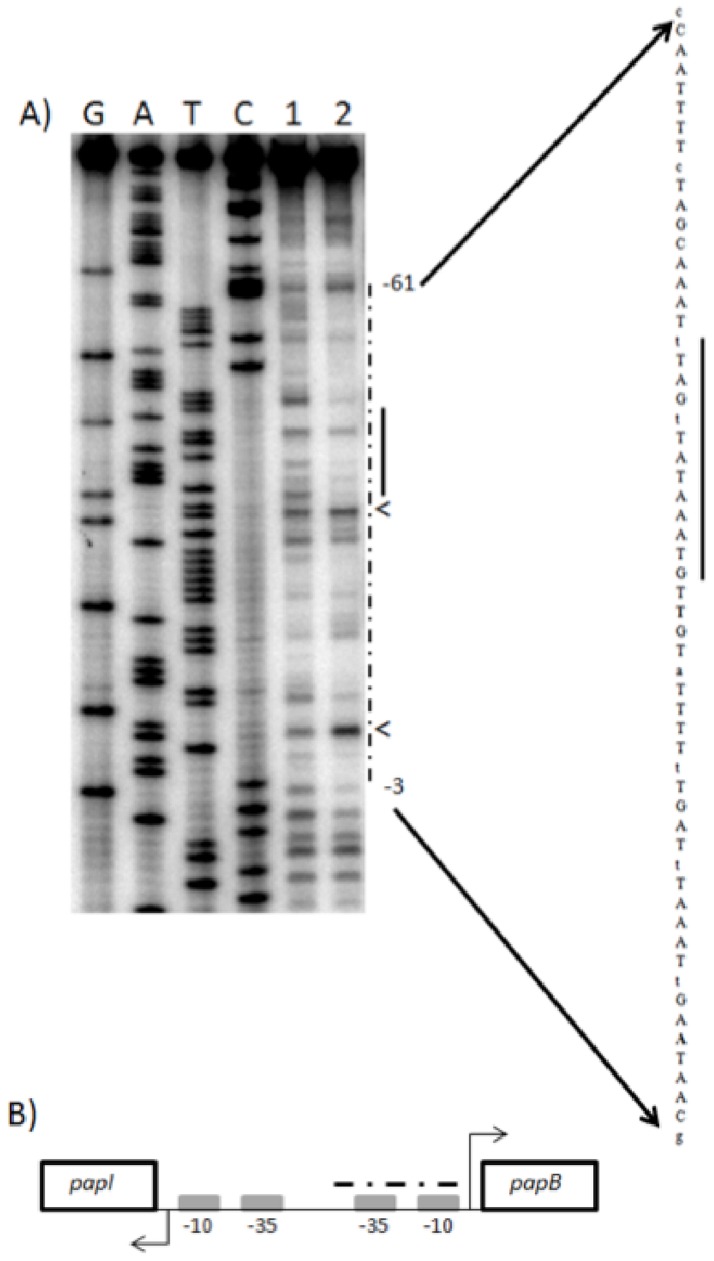
IHF binds the upstream region of papB.A) Lane 1–2: 0 & 50 nM IHF were incubated with labeled probe and subjected to DNase I digestion. The sequence protected by IHF is marked with the dashed line on the gel and the actual sequence is shown on the right side of the figure. The solid line on the sequence and gel represent the IHF recognition site, bold bases indicate the hypersensitive sites (< on the gel) and lower case letters are not protected. The numbers indicate the position from the transcription start (+1) of papB. B) Organization of the divergent papB and papI promoter region with the IHF protected region indicated by the dashed line.